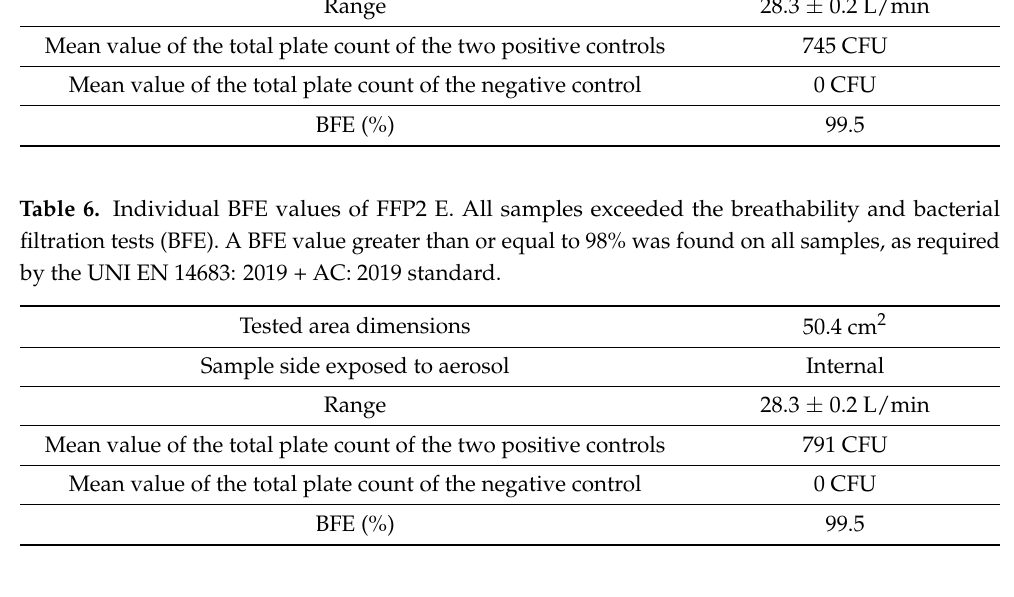
Table 7. Individual BFE values of FFP2 F. All samples exceeded the breathability and bacterial filtration tests (BFE). A BFE value greater than or equal to 98% was found on all samples, as required by the UNI EN 14683: 2019 + AC: 2019